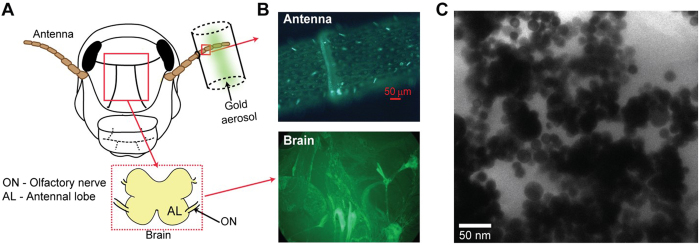
Uptake and translocation of AuNPs in the locust olfactory pathway.(A) A schematic of the experimental setup is shown. FITC functionalized, gold nanoparticle were aerosolized and delivered onto locust antenna. Inset reveals the details of the early invertebrate olfactory pathway. (B)
Top, An image of a segment of the locust antenna after AuNP aerosol exposure is shown. Notice that sensory hairs (cone like structures on the antenna surface) show different levels of fluorescence. Bottom, Similar fluorescence image of a brain segment is shown. (C) TEM micrograph of a brain slice confirms accumulation of AuNPs in the locust brain.